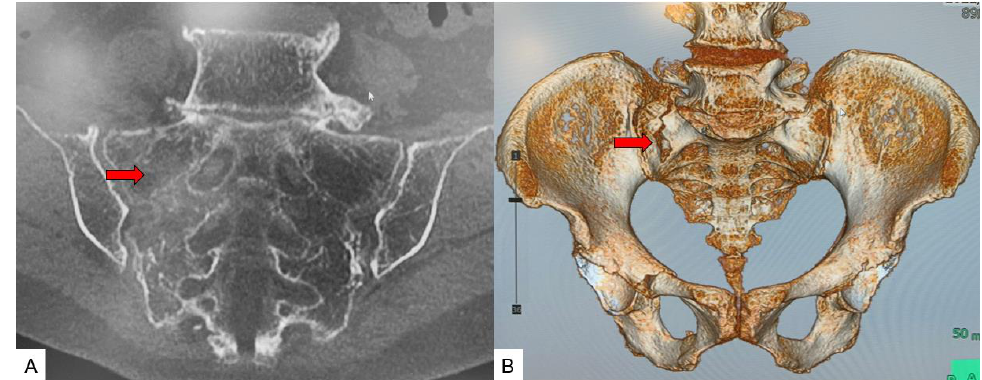
Figure 9. 89-year-old woman, unilateral vertical-type fracture of SIF. ( A ): Coronal CT, ( B ): 3D CT, red arrows indicate fracture line.